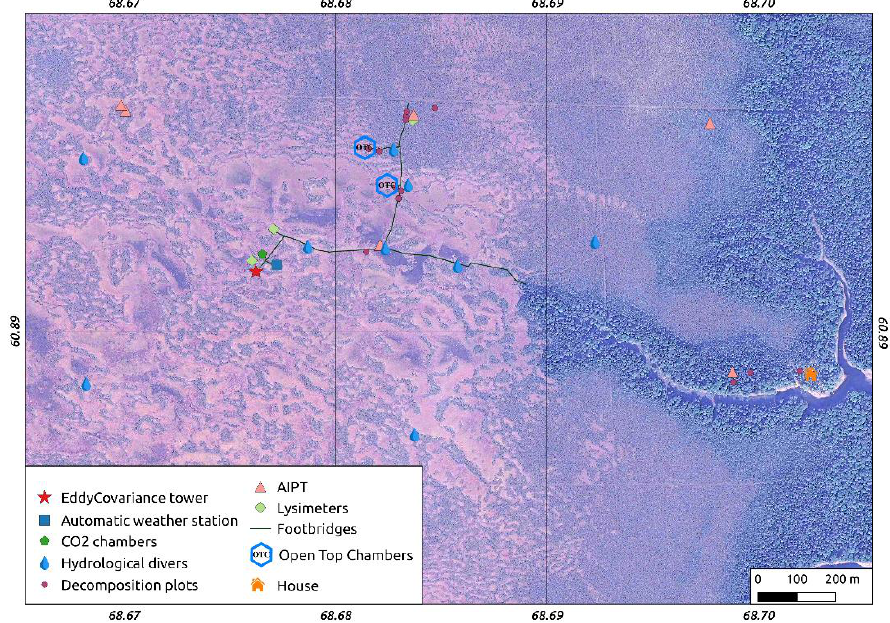
Figure 3. Location of the monitoring plots and